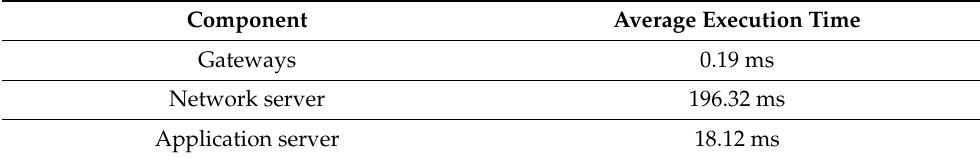
Table 1. Average Execution Time of the Fog Components for 1000 Requests. Table 2. Average Execution Time of the Fog Components for 5000